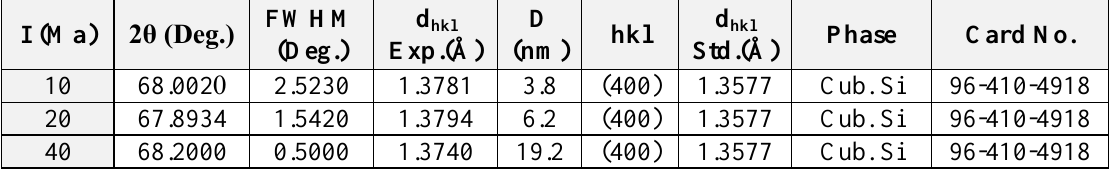
Table 1: Structural parameters: 2θ, d , (hkl), FWHM and crystallite size (D) of p-PS at hkl current densities (10, 20 and 40) mA/cm 2 at 10 min etching time.